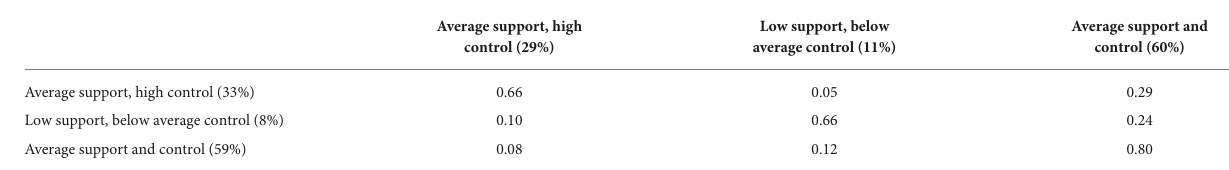
TABLE 3 Latent transition probabilities between grades 6 and